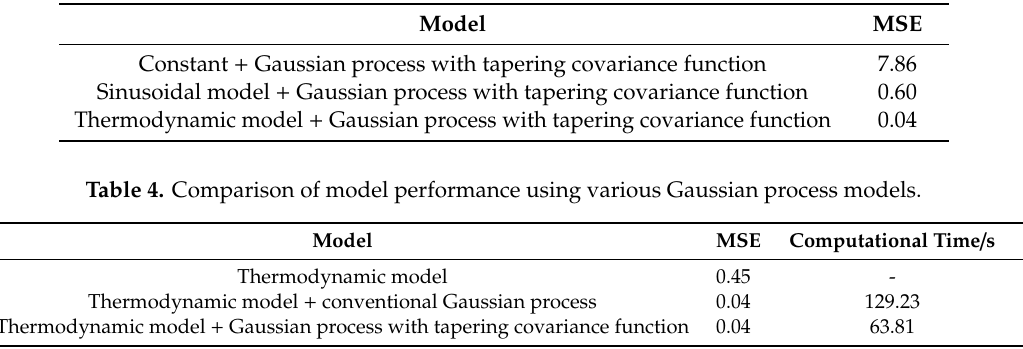
Table 4. Comparison of model performance using various Gaussian process models.